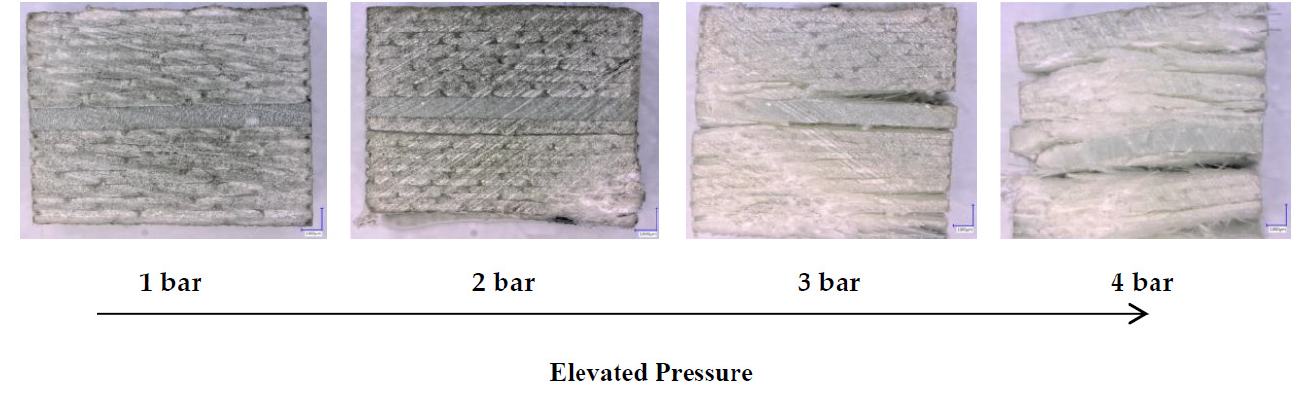
Figure 12. Optical micrographs of bonded composite under dynamic compression for t = 216 h.